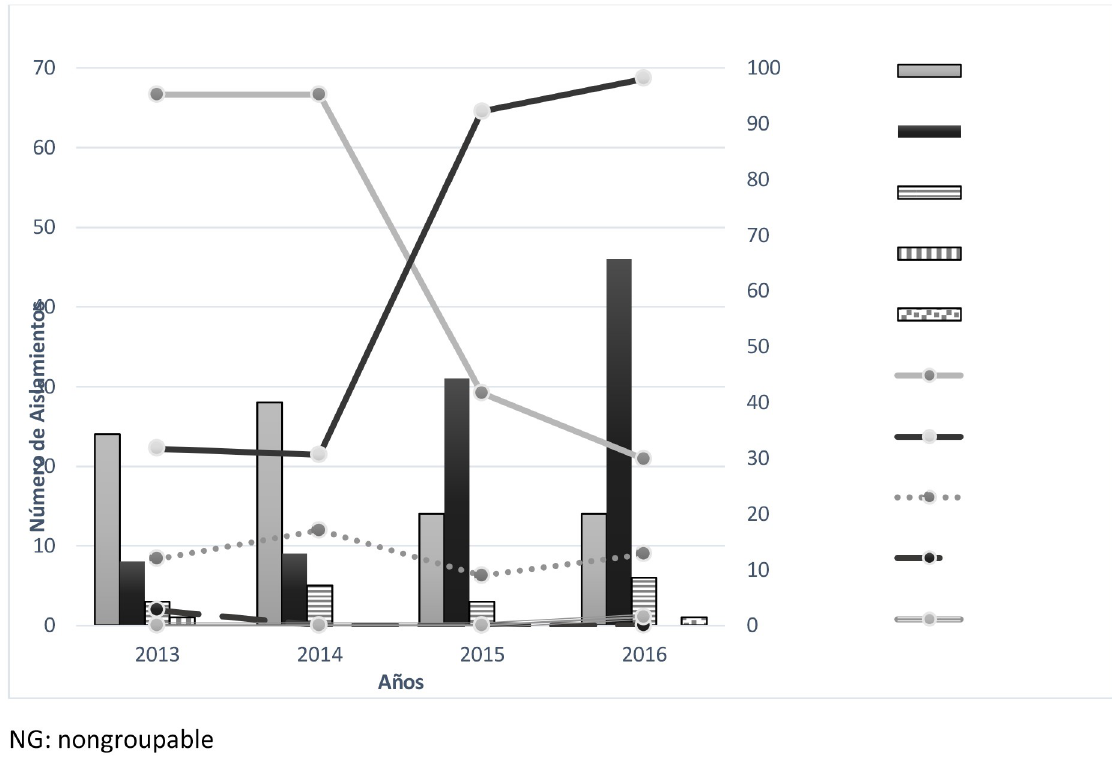
Fig 1. Serogroup distribution of meningococcal disease in Colombia from 2013 to 2016.